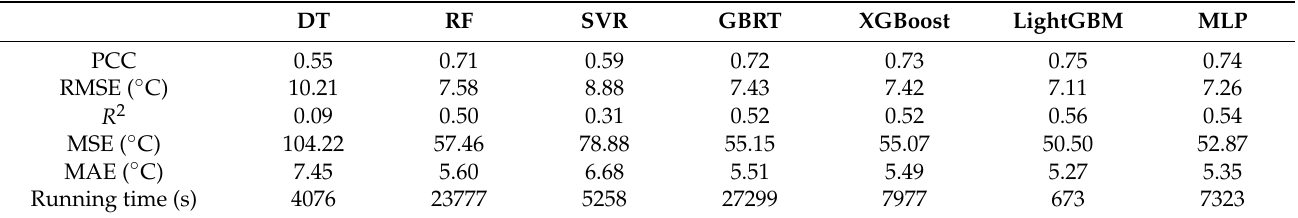
Table 3. Performance of machine learning regression algorithms with all features in 10-fold cross-validation.